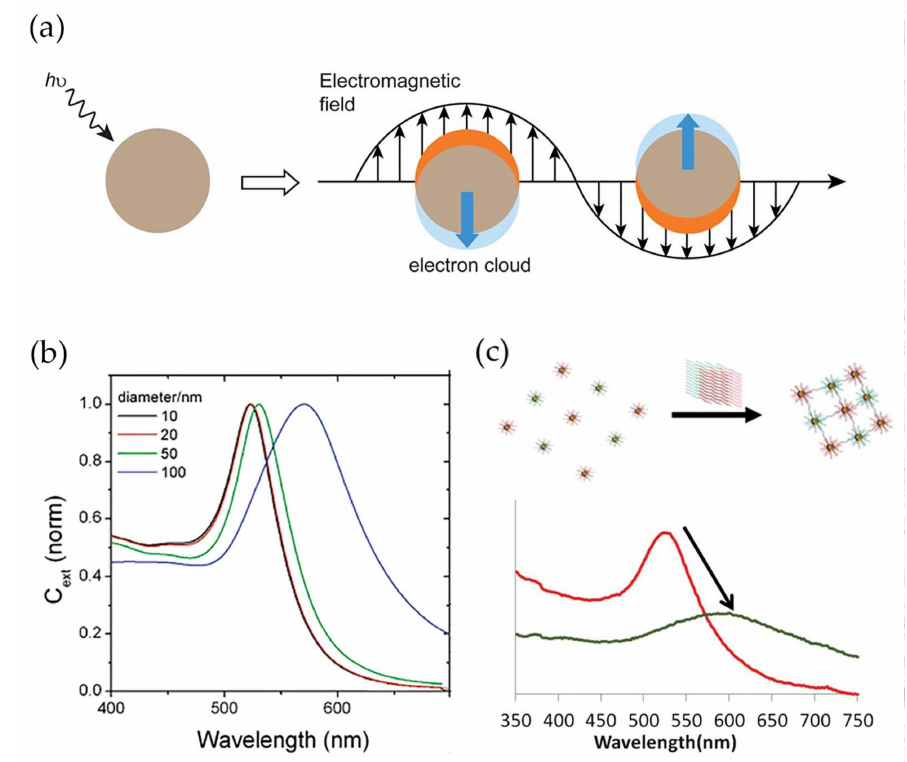
Figure 1. ( a ) Schematic illustration of localized surface plasmon resonance effect. Conduction electrons oscillate across the metal nanoparticle owing to the electromagnetic field of the incident light. Reproduced with permission from ref. [30]. Copyright The Royal Society of Chemistry, 2012; ( b ) Dependence of localized surface plasmon resonance (LSRP) band wavelength to average diameter of spheroidal gold nanoparticles. Reproduced with permission from ref. [23]. Copyright American Chemical Society, 2006; ( c ) Variation in LSPR band between modified gold nanoparticles (red) and modified gold nanoparticles conjugating after recognizing the target (green). Reproduced with permission from ref. [31]. Copyright The Royal Society of Chemistry,